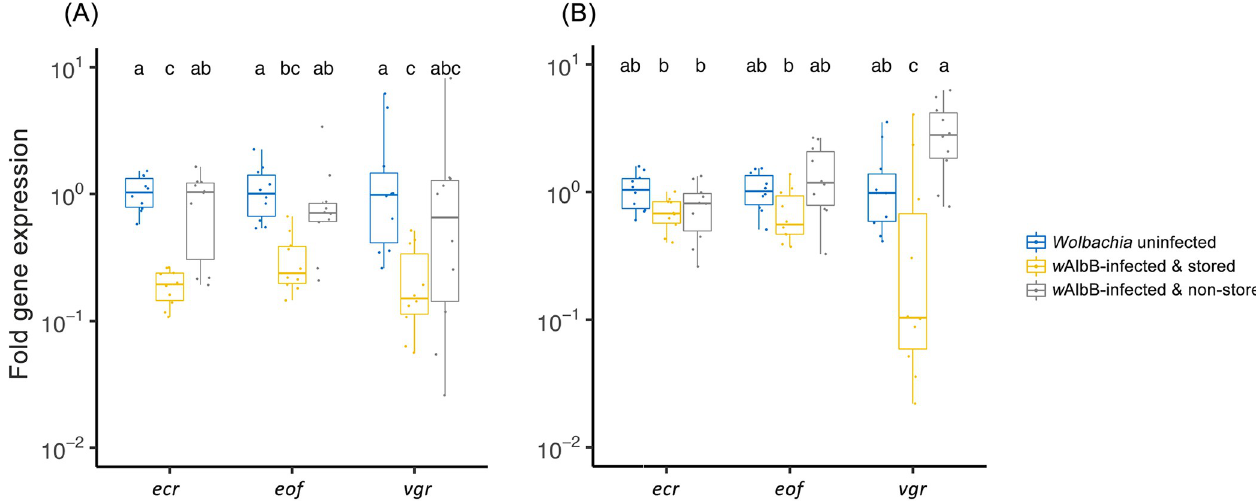
Fig 3. Boxplots of relative expression of reproduction-related genes ecdysone receptor ( ecr ), eggshell organizing factor ( eof ) and vitellogenin receptor ( vgr ) in female (A) pupae and (B) young adults (1 ± 0.5 days post-emergence). These three genes were normalized to reference gene RPS17 . Values with the same letter are not significantly different based on Tukey’s HSD tests (S5 Table). Results are based on two consistent real-time PCR replicates of ten individual females from each group.